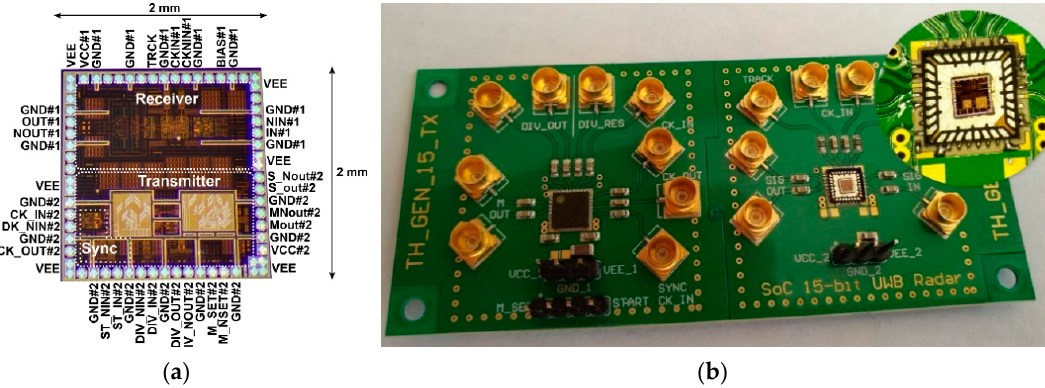
Figure 5. Integrated UWB radar SoC: ( a ) magnified view of the bare die and ( b ) evaluation module—transmitter (left) and receiver (right).